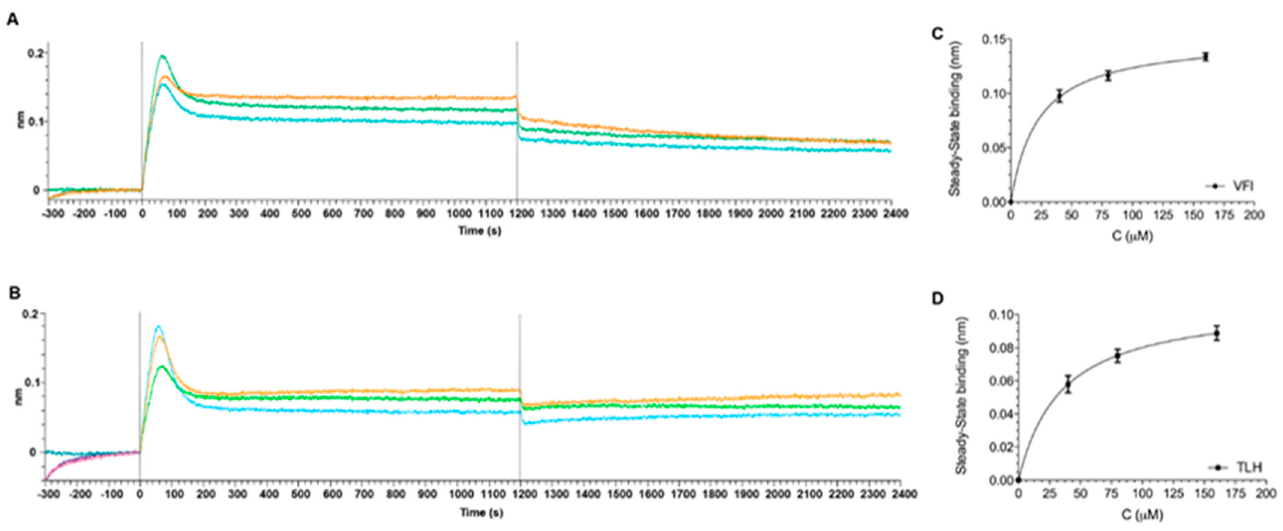
Figure 7. BLI interaction analysis. RBD (0.2 μ M) ( A , B ) either alone in solution or mixed with VFI ( A ) and TLH ( B ) peptides, tested at different concentrations (40 μ M, blue lines; 80 μ M, green lines and 160 μ M, orange lines). BLI interaction was performed at 25 °C in PBST (10 mM phosphate, 150 mM NaCl, 0.05% Tween 20, pH 7.4). The corresponding plots ( C , D ) of steady-state binding from the end of the association phases (nm), after the subtraction of RBD signal, against analyte concentration were used to calculate the steady-state affinity by nonlinear regression analysis using GraphPad 5 software.